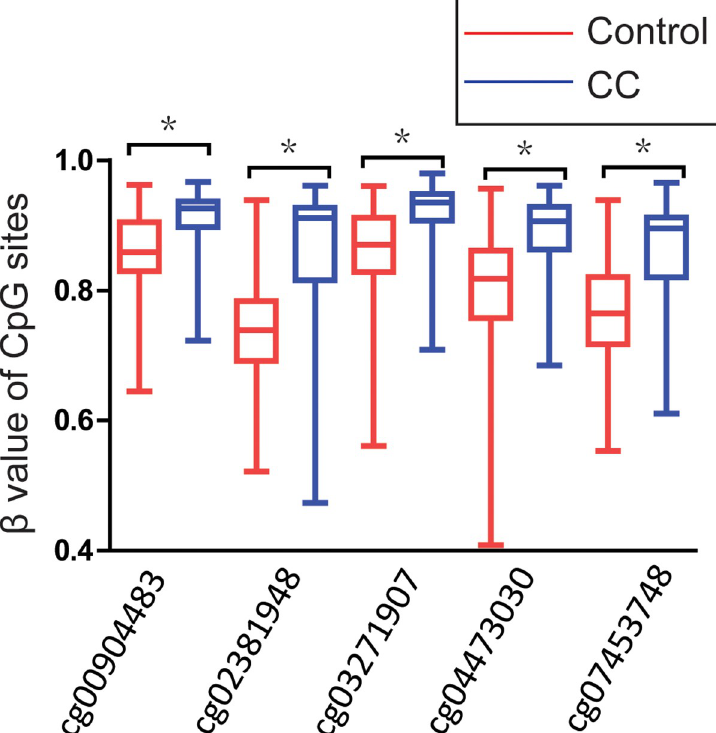
Fig 8. Significant differences of methylation level in 5 CpG sites of MGMT between cervical cancer and controls in GEO dataset. P -value were calculated by the Mann-Whitney U test. � P < 0.001.